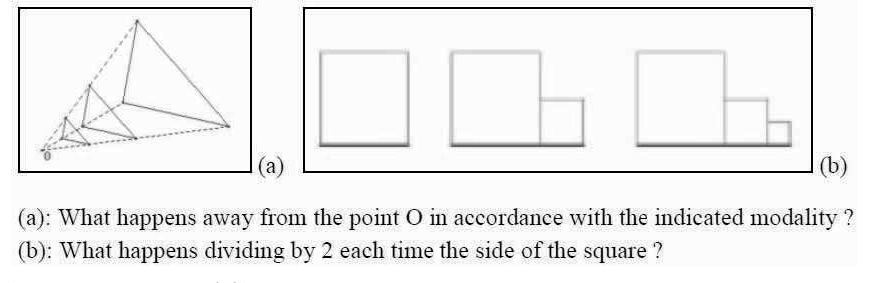
Figure 7. Convergent and divergent processes Source: personal